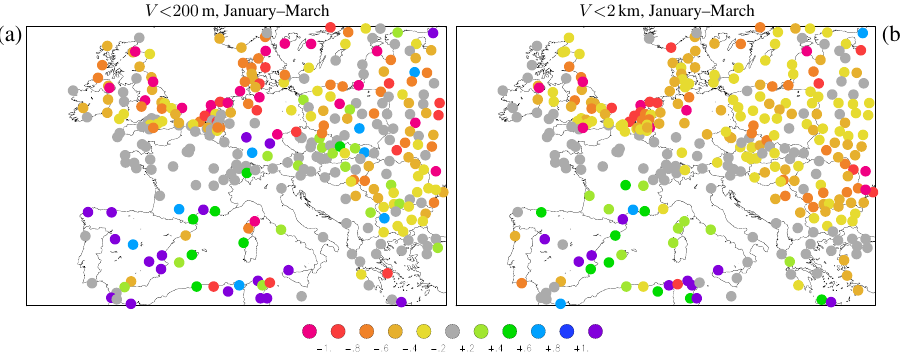
Fig. 18. As Fig. 17 but only taking zonal geostrophic wind U into account.